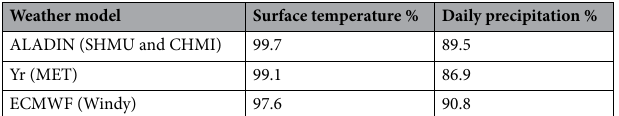
Table 3. Overview of relative accuracies (RA) of weather prediction models produced for both countries.